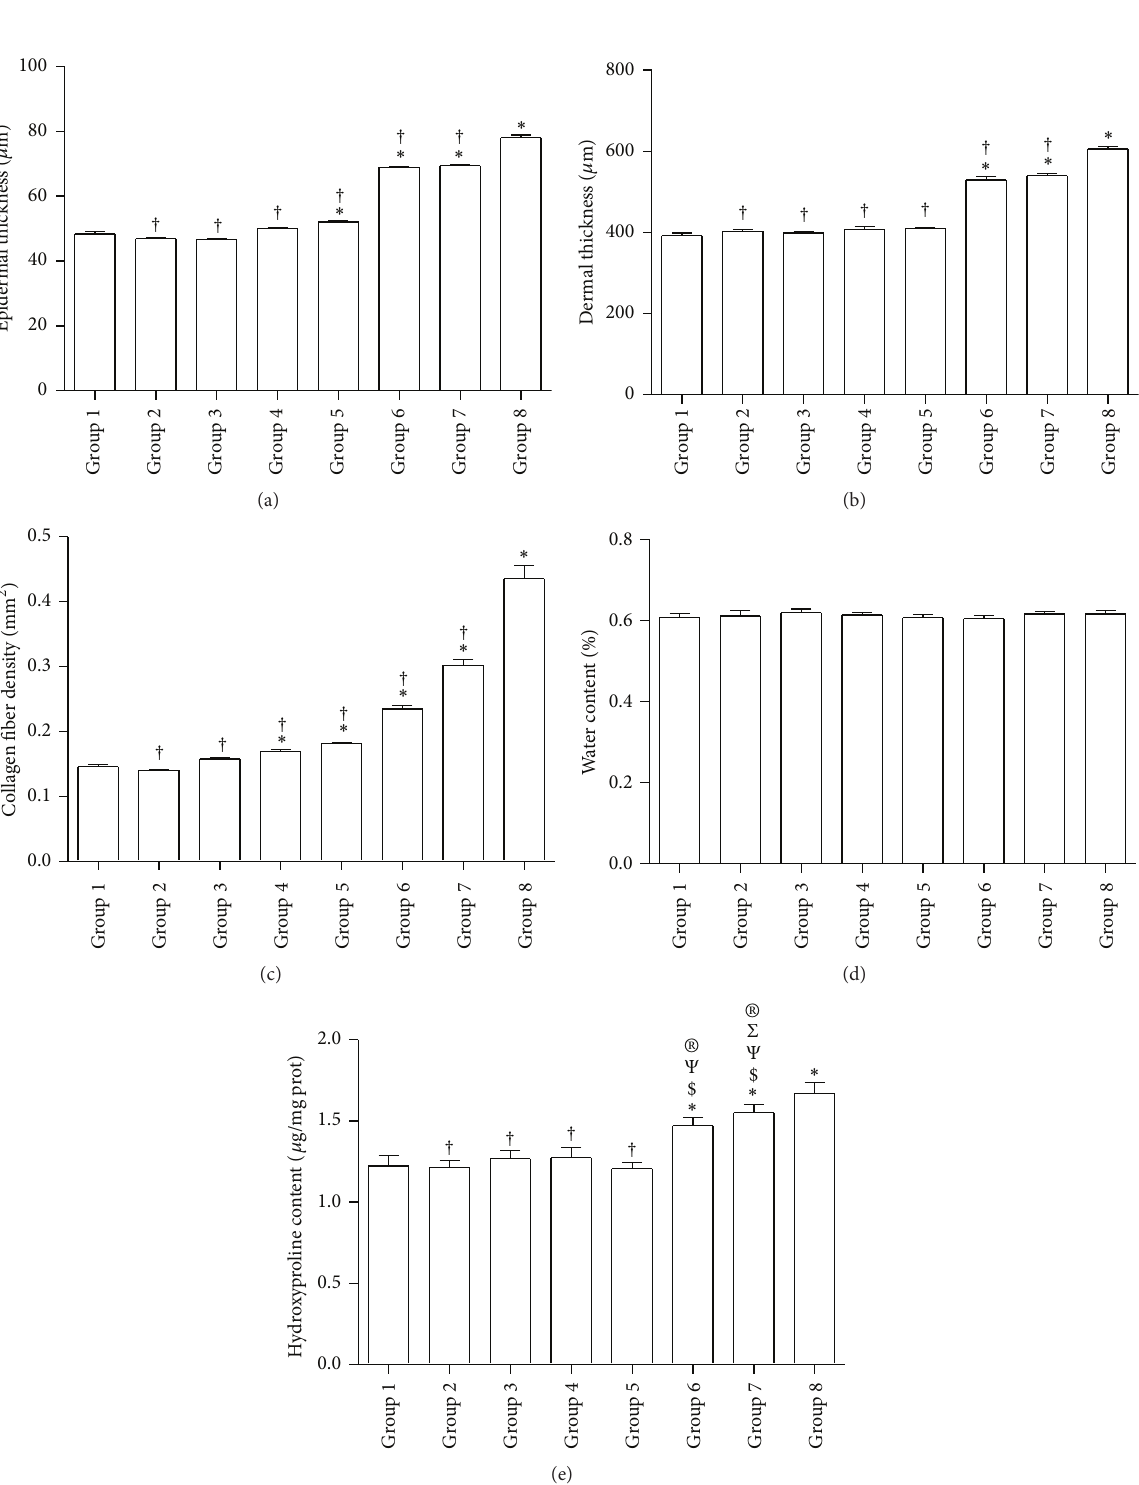
Figure 2: Physical properties of D-gal induced aging skin wound after each treatment. (a) Epidermal thickness ( 𝜇 m), (b) dermal thickness ( 𝜇 m), (c) collagen fiber density (mm 2 ), (d) water content (%), (e) hydroxyproline content ( 𝜇 g/mg protein). ∗ , † , $, Ψ , Σ , and Ⓡ denote a significant difference ( 𝑃 < 0.05 ) relative to negative control, sham control, NS, AA, 0.1% DMAE, and 0.2% DMAE, respectively. For water content assay, no significant difference existed among all treatment